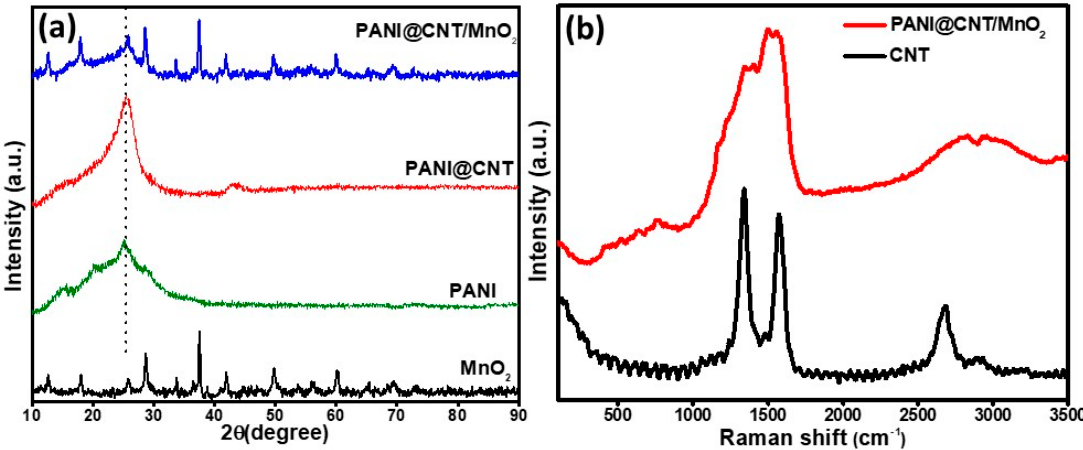
Figure 3. ( a ) X-ray diffraction (XRD) pattern of the MnO 2 , PANI, PANI@CNT binary